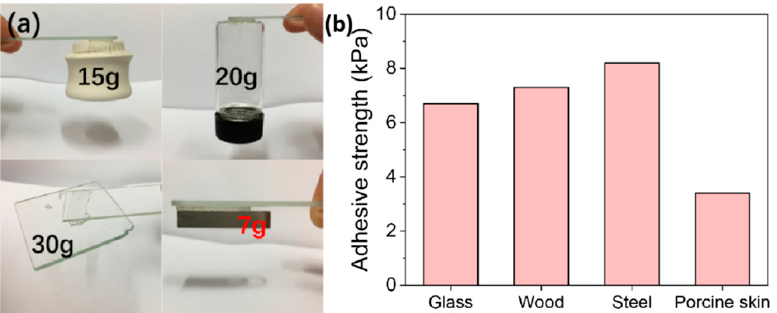
Figure 5. ( a ) Adherence of the hydrogel to loads of 7–30 g. ( b ) Adhesion strength of the hydrogel to glass, wood, steel, and porcine skin